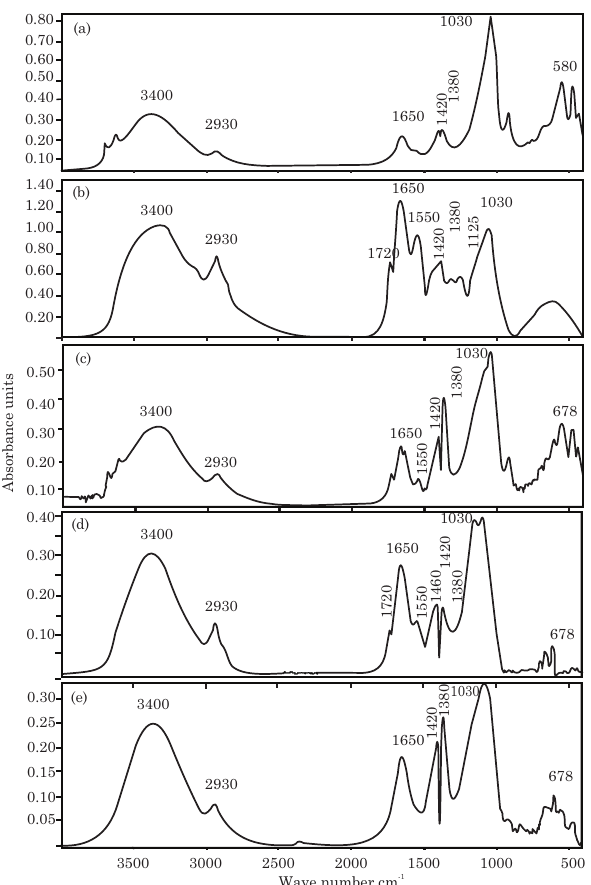
Figure 2. Infrared spectra of humic acids: (a) unamended soil (prior to the experiment), (b) sewage sludge (SS), (c) inorganic fertilizer-soil (S-230), (d) sewage sludge-treated soil, low rate (SL-230), (e) sewage sludge-treated soil, high rate